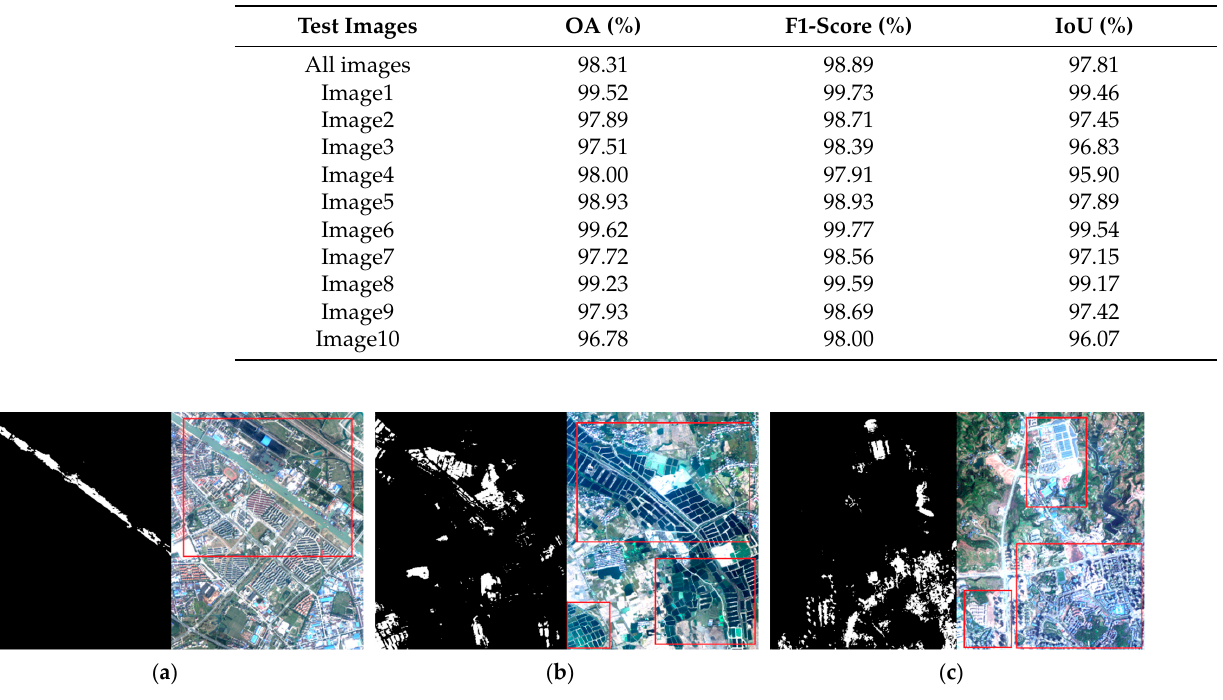
Table 2. Results of OA, F1-score and IoU on the validation images.